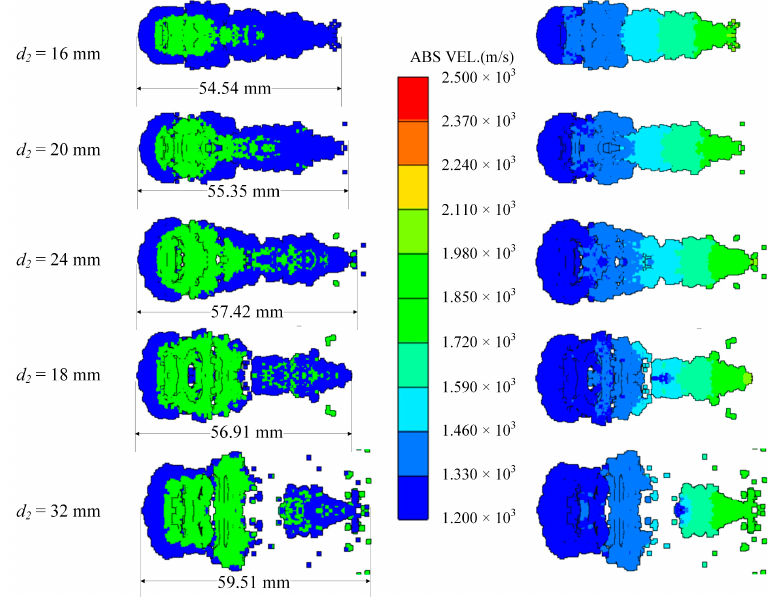
Figure 16. Coating shapes and velocity distribution as the diameter of the reactive liner changes.